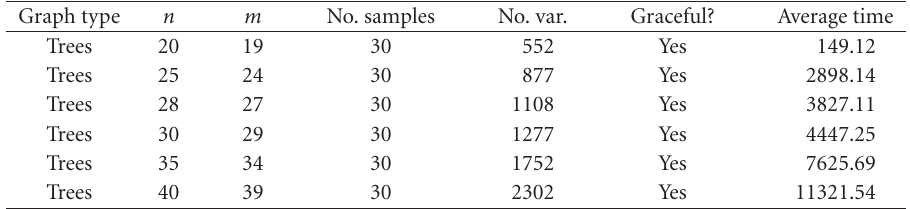
Table 4.3. The results of solving the model for di ff erent classes of